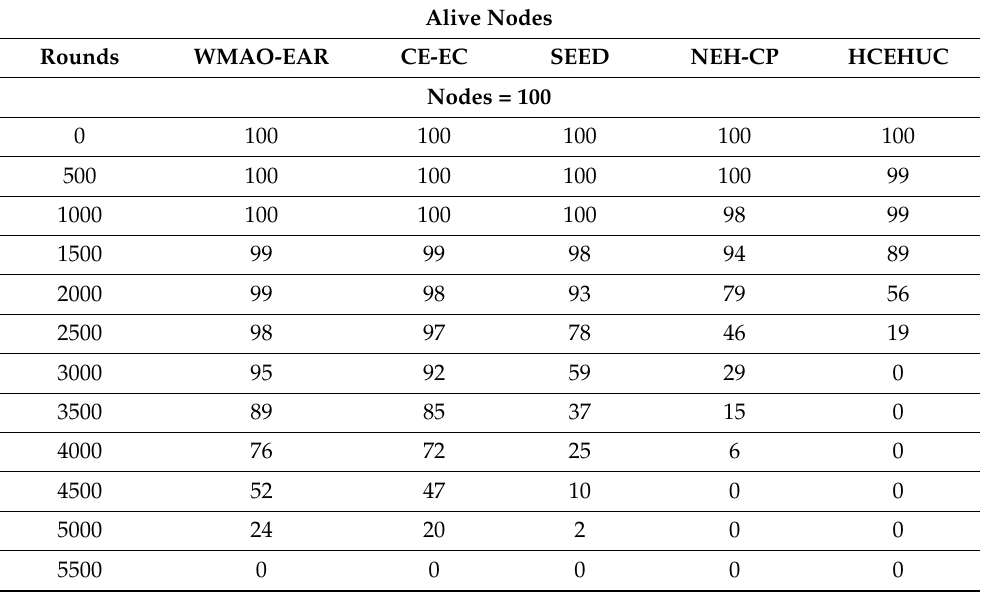
Table 3. NOAN analysis of WMAO-EAR approach with existing algorithms under NC of 100 and 300.